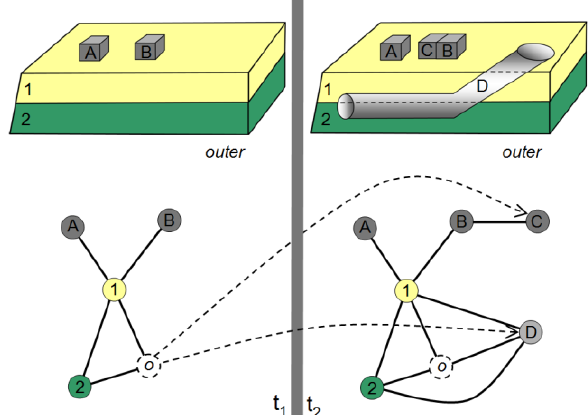
Figure 11. Change of a city by building activity. The state of a city between t 1 and t 2 changes by man-made